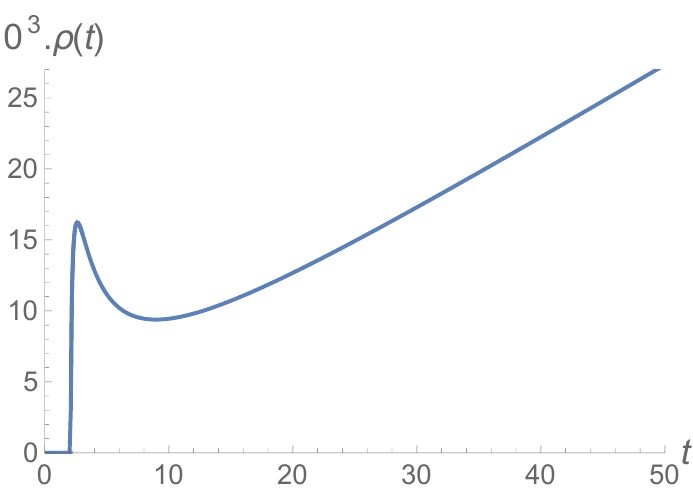
Figure 12 . Spectral function for reduced transverse propagator of the vector composite operator h V ( p ) V ( (cid:0) p ) i T , with all quantities given in units of appropriate powers of the energy scale (cid:22) , for the parameter values e = 1, v = 1 (cid:22) , (cid:21) = 1 5